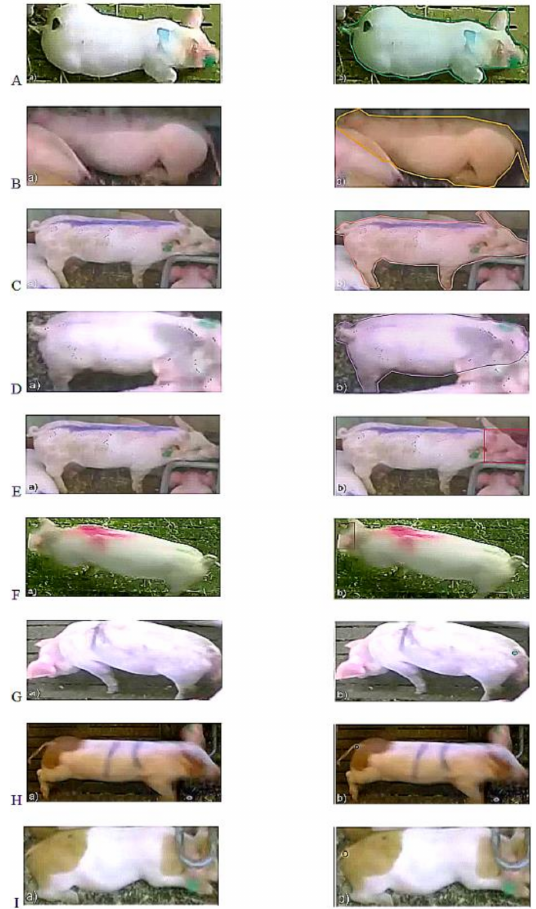
Figure 3. Enlarged examples of good and bad visibility of pigs (lying or standing), faces and tails (curled or straight) for annotation (left, ( a ) = original; and right, ( b ) = annotated), from top to bottom: ( A ) pig lying—good visibility; ( B ) pig lying—bad visibility; ( C ) pig standing—good visibility; ( D ) pig standing—bad visibility; ( E ) face—good visibility; ( F ) face—bad visibility; ( G ) curled tail—standing; ( H ) straight tail—standing; and ( I ) tail uncertain or